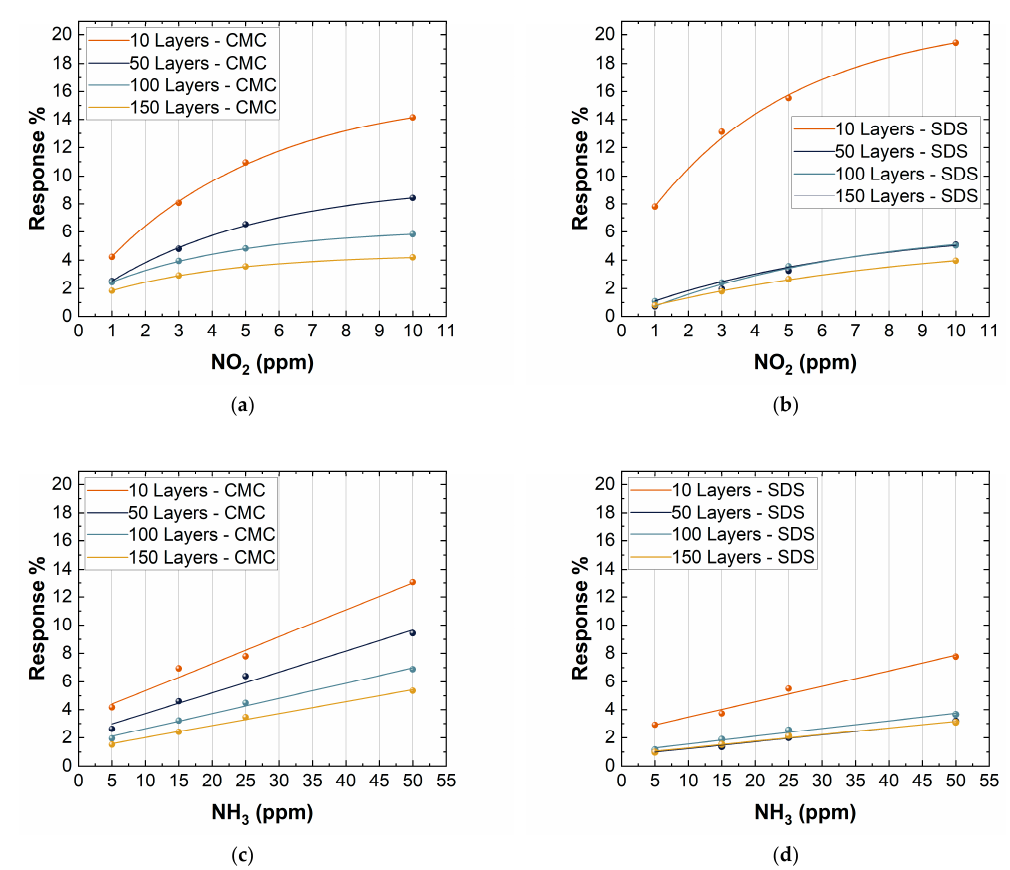
Figure 9. Response to 1, 3, 5, and 10 ppm NO ₂ of: ( a ) CMC-based sensors with 10, 50, 100, 150 layers; ( b ) SDS-based sensors with 10, 50, 100, and 150 layers. Response to 5, 15, 25, and 50 ppm NH ₃ of: ( c ) CMC-based sensors with 10, 50, 100, and 150 layers; ( d ) SDS-based sensors with 10, 50, 100, and 150 layers.